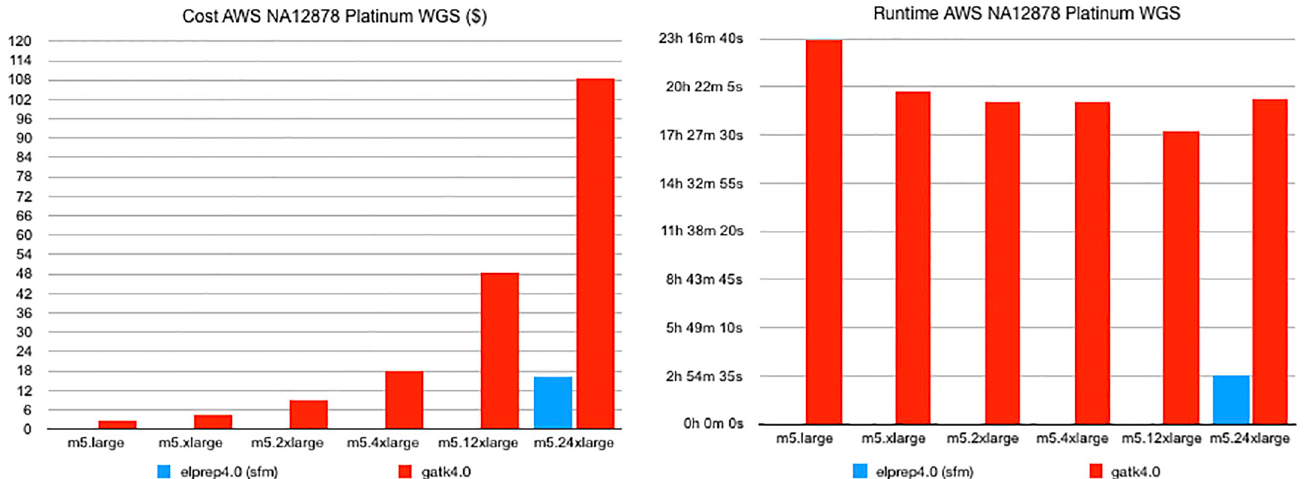
Fig 5. AWS WGS benchmarks. The dollar cost and runtime on Amazon Web Services for running a 4-step pipeline on a whole genome using GATK 4 versus elPrep 4. While GATK 4 is able to run on a wider range of Amazon instances, the overall runtime is much larger compared to elPrep 4. The fastest run with GATK 4 takes over 17.5 hours on m5.12xlarge and costs 48.71$, whereas the elPrep 4 run takes a bit less than 3 hours and costs only 16.25$ on m5.24xlarge, being almost 6x faster for 3x less money.